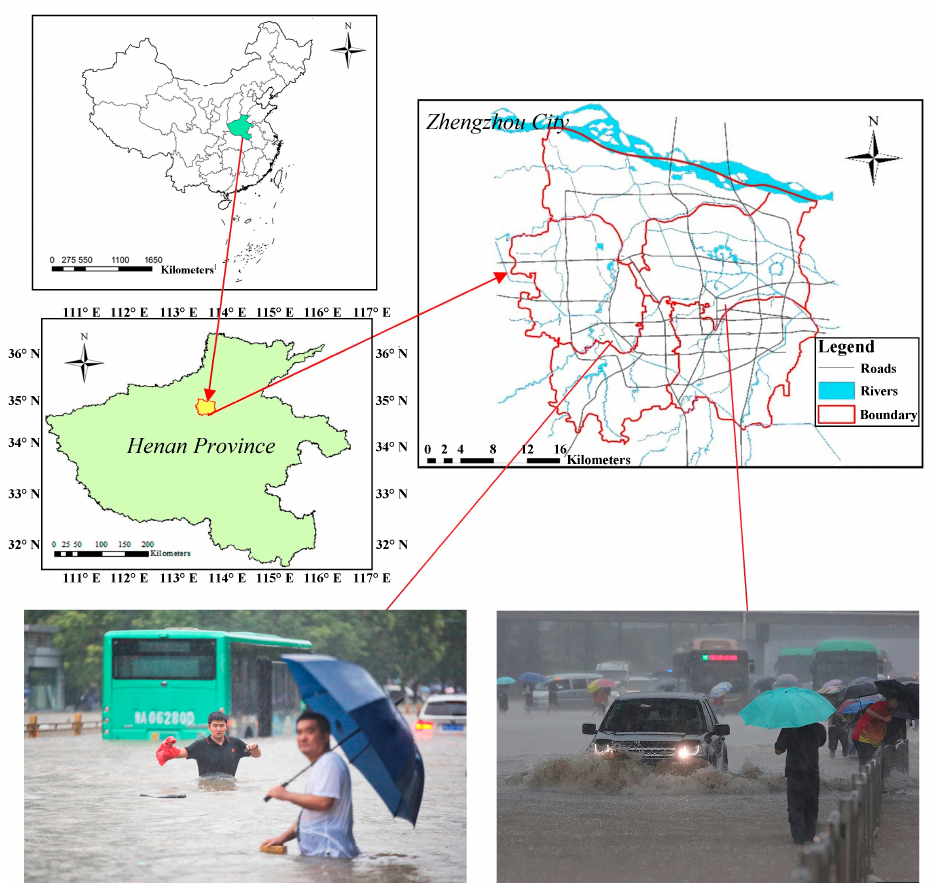
Figure 2. The geographical location of Zhengzhou and the heavy rain disaster that occurred in Zhengzhou on 20 July 2022.